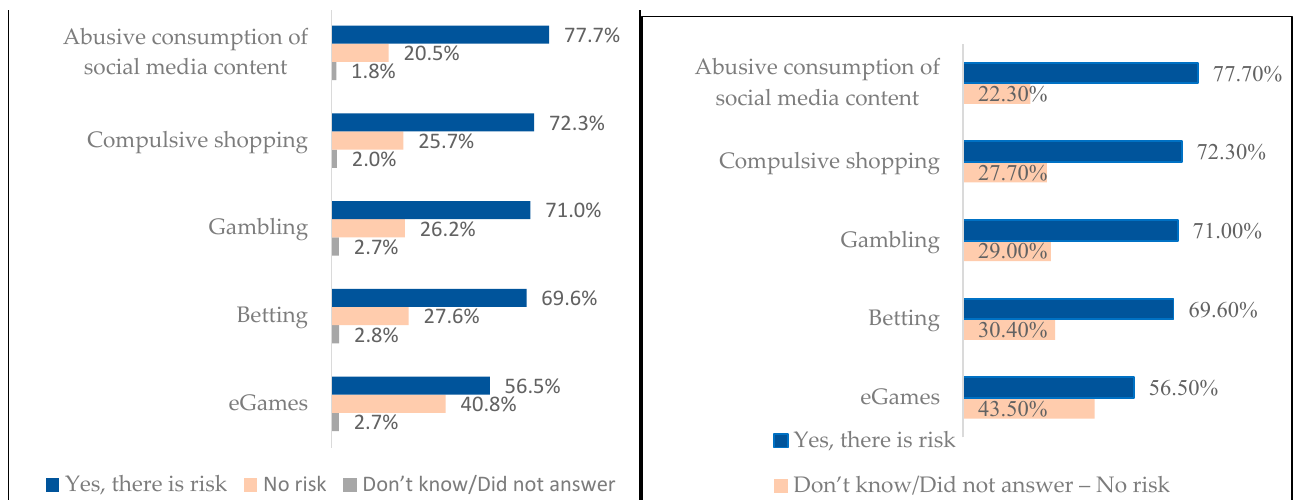
Figure 1. Perception of risk or danger in risky online activities. Source: own work.